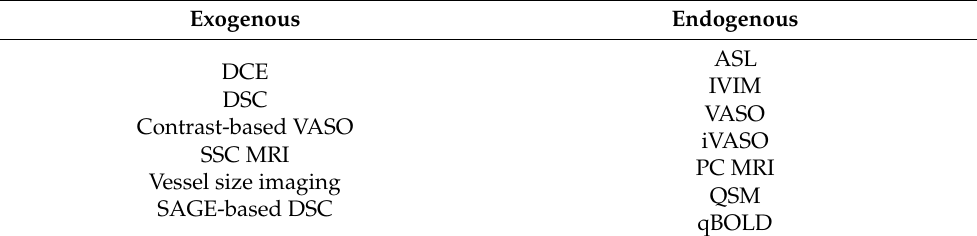
Table 1. Overview of the MRI techniques discussed in this